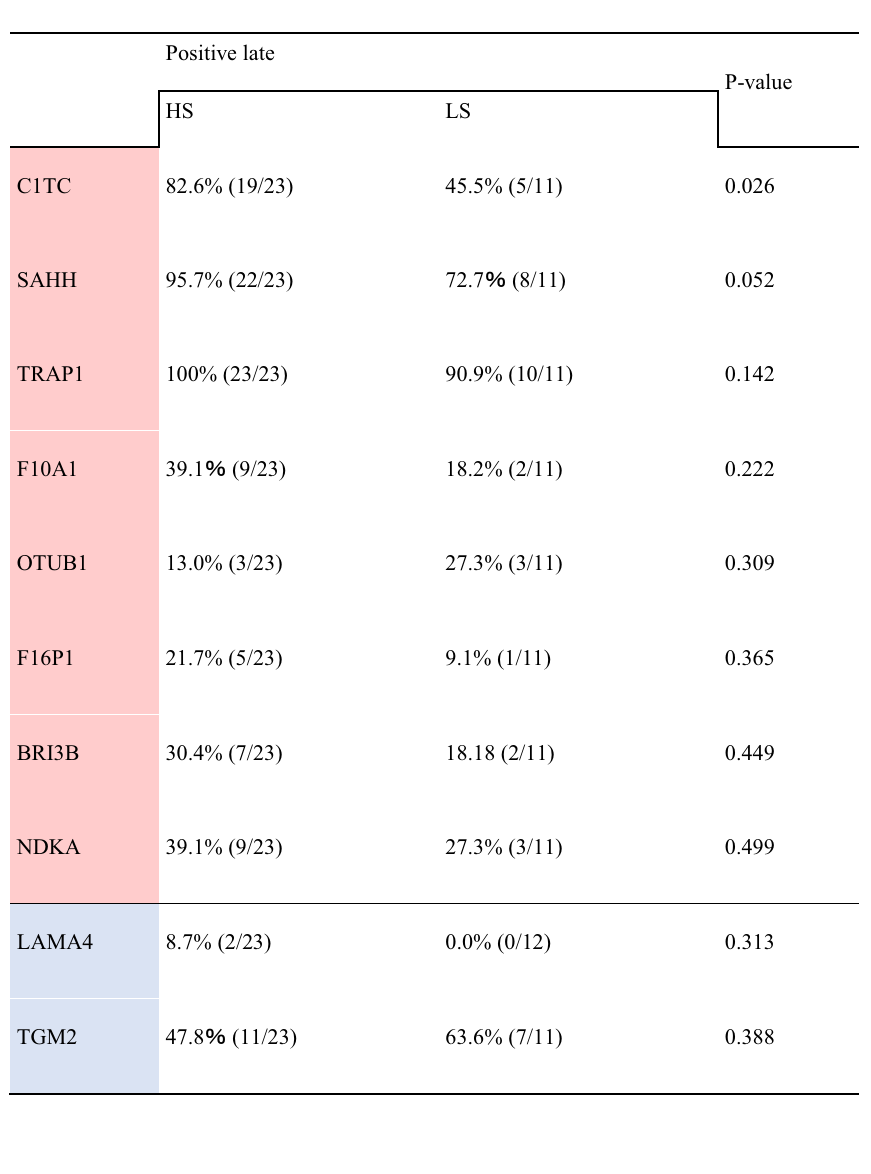
Table 1. Clinicopathological background of LC–MS/MS